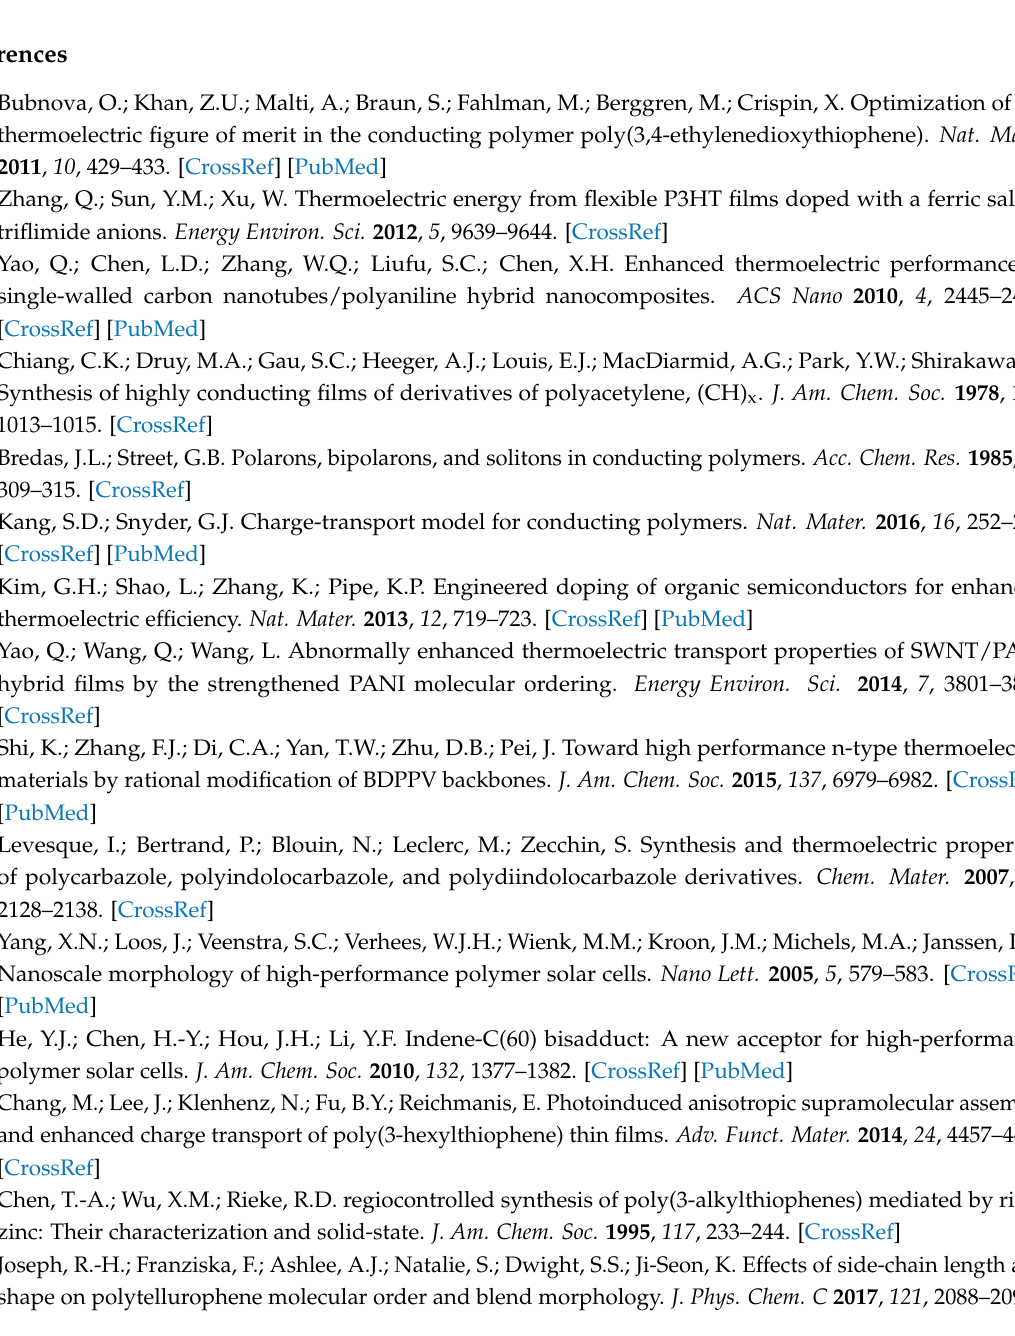
Table S1: Thermoelectric properties of self-assembly ra-P3HT and rg-P3HT, Table S2: Number Average Molecular Weight ( M n ), Weight Average Molecular Weight ( M w ) and Polydispersity Coefficient ( P i ) of ra-P3HT and